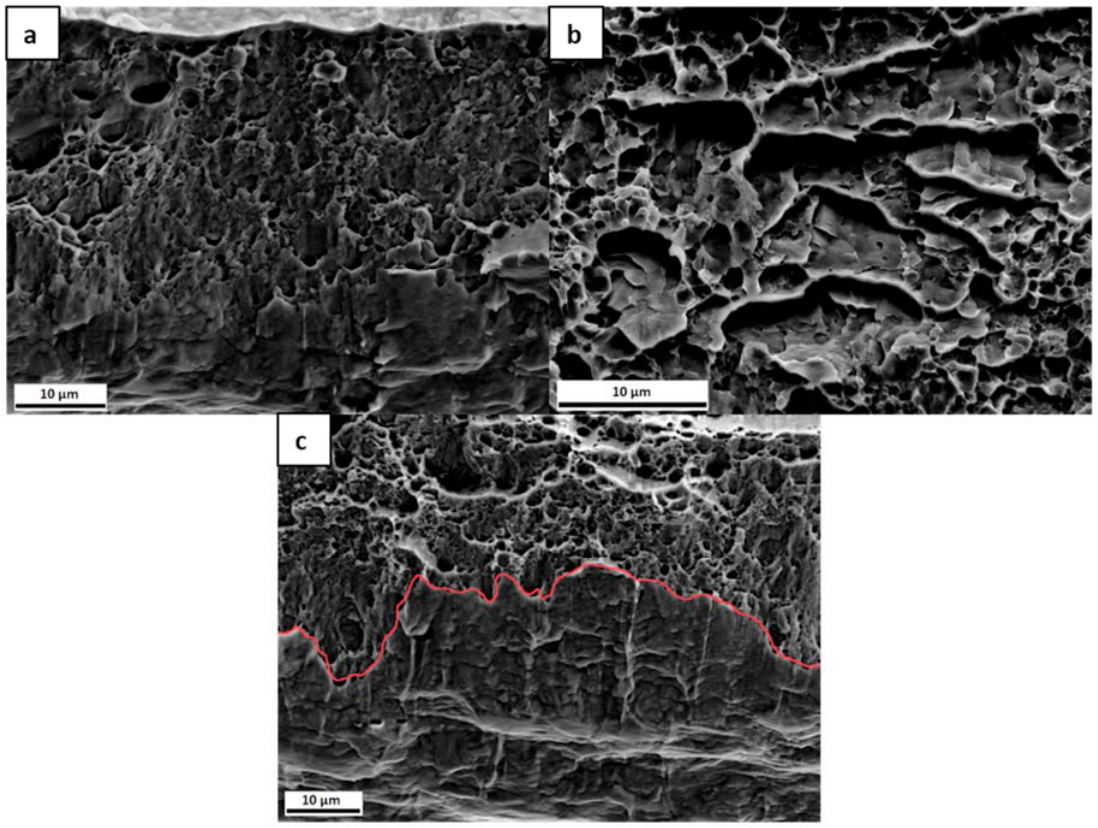
Figure 7. Fracture surfaces of the ( a ) uncharged; ( b ) 3 h pre-charged; and, ( c ) 6 h pre-charged CP steel samples.